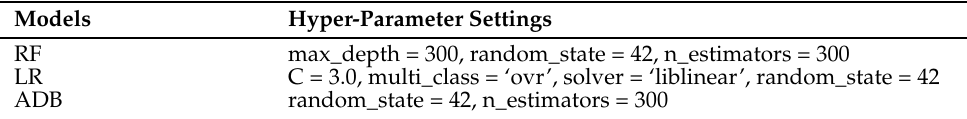
Table 6. Machine Learning Models Hyper-parameter